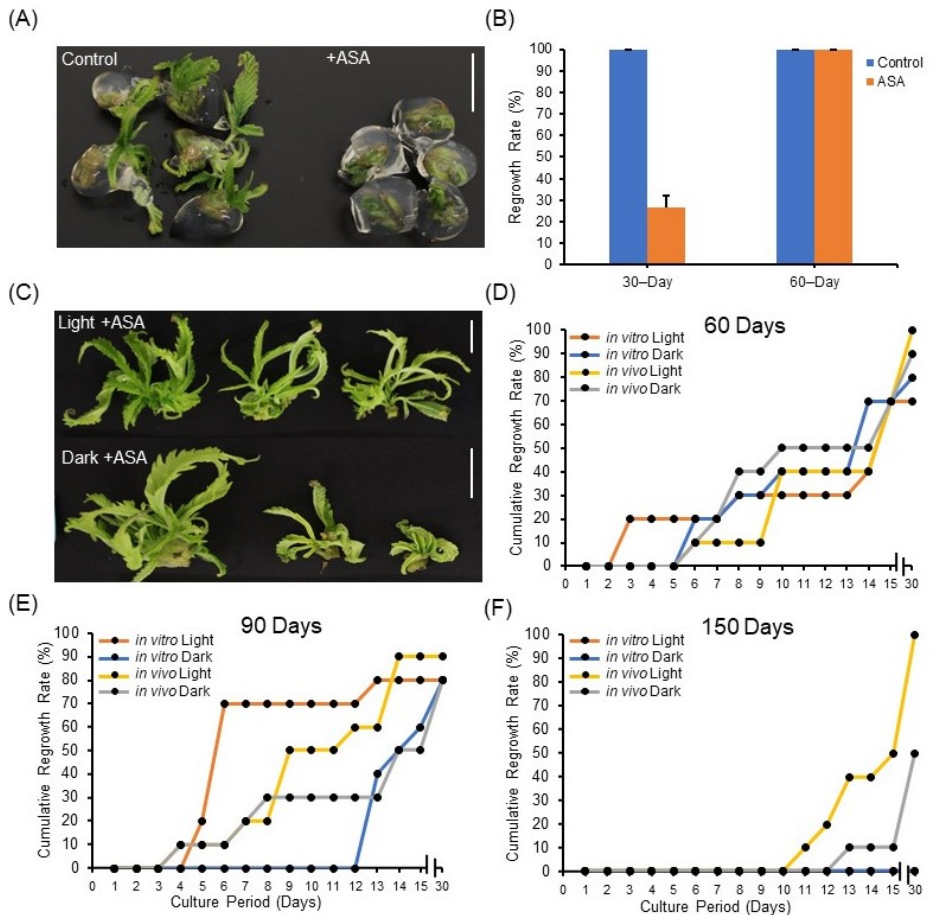
Figure 3. Impact of acetylsalicylic acid (ASA) on synseed storage and regrowth rates. Representative synseeds ( A ) and the corresponding precocious germination rate during 30 and 60 days of storage at 22 ◦ C with or without 25 µ M ASA ( B ). Representative synseeds supplemented with 25 µ M ASA and stored for 60 days light or dark and regrown for 30 days on MS medium ( C ). Thirty-day cumulative regrowth rates of 25 µ M ASA treated synseeds derived from in vitro or in vivo plants after 60 ( D ), 90 ( E ), and 150 day ( F ) storage at 6 ◦ C under 50 µ mol s − 1 m − 2 light and an 18/6 h photoperiod or dark exposure. Scale bars represent 1 cm.